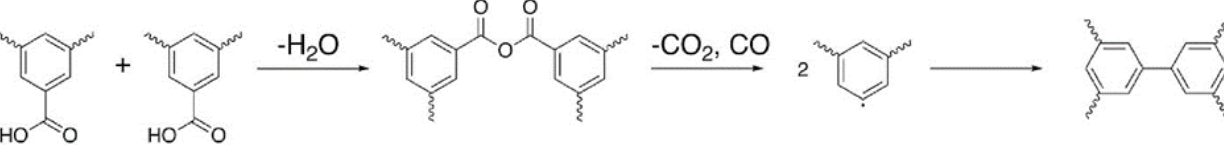
Figure 8. Chemical structure of 6FDA-based polyimide precursors.